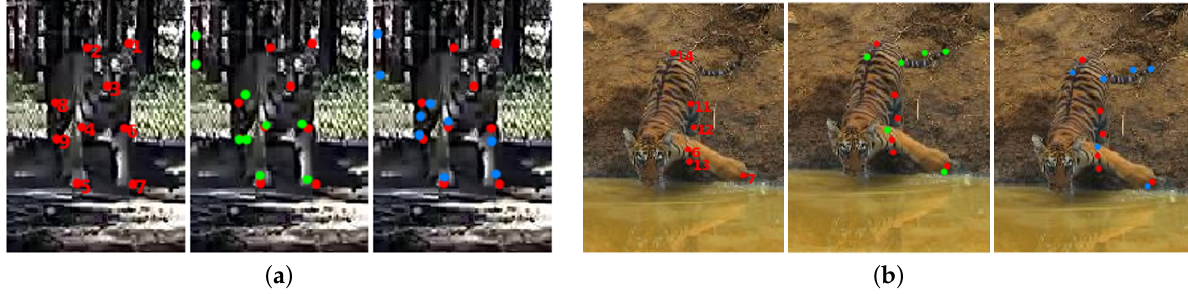
Figure 8. Failure Cases. Example in ( a ) Amur, and ( b ) TD-Tiger. The red point, green point, and blue point represent the ground truth, the initially estimated pose, and the refined pose, respectively. The number represents the index of the joint